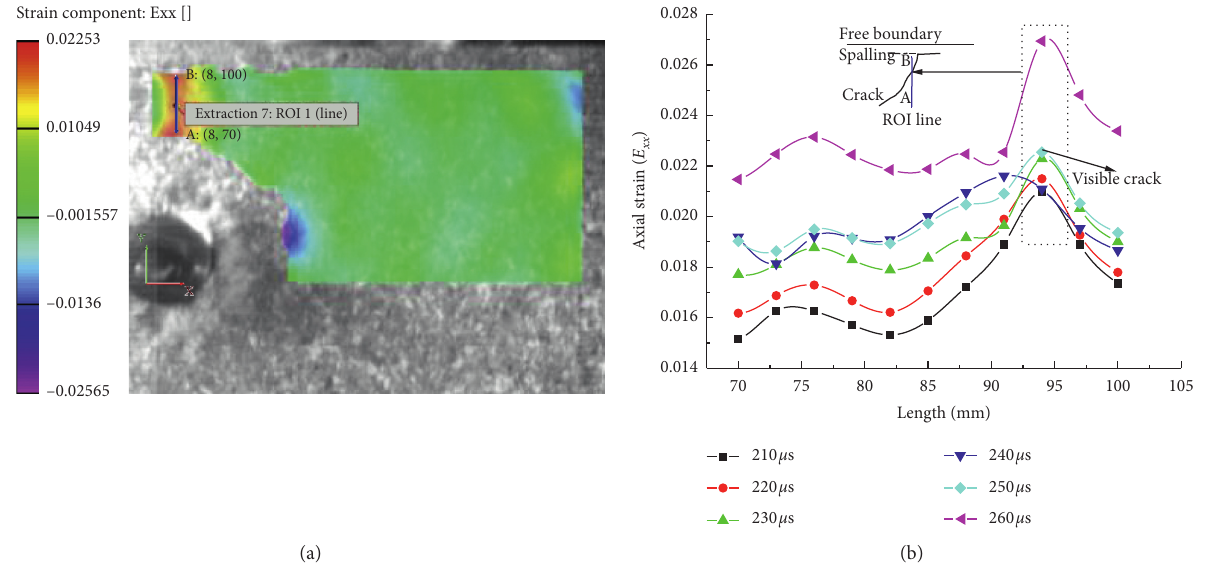
Figure 5: Axial strain for test 2. (a) Axial strain field at 210 µ s and (b) curves of axial strain.